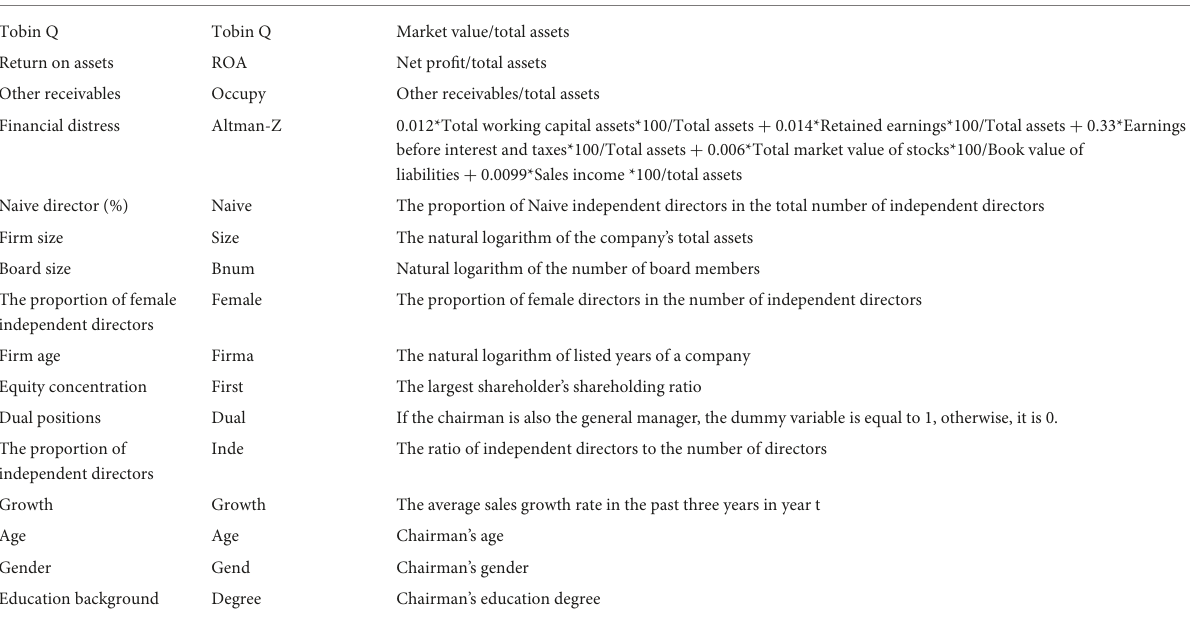
TABLE 1 Variable definition.